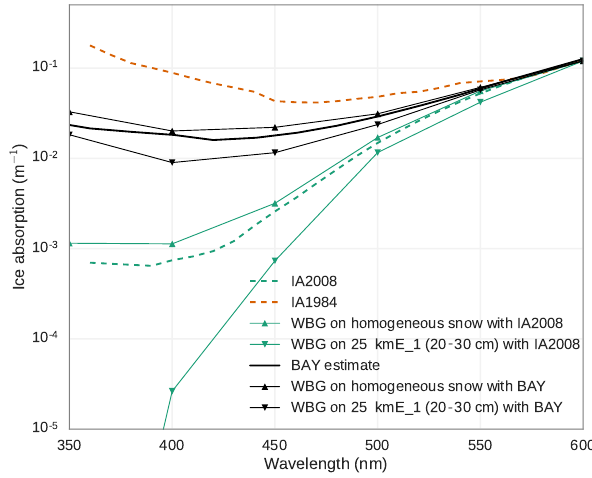
Figure 16. Ice absorption estimated with the WBG method applied to simulated irradiance profiles with MCML in the presence of the rod for the homogeneous snowpack (triangles up) and the 25kmE_1 snow pit (triangles down) by using IA2008 (green) and BAY (black) ice absorption spectra, respectively, as